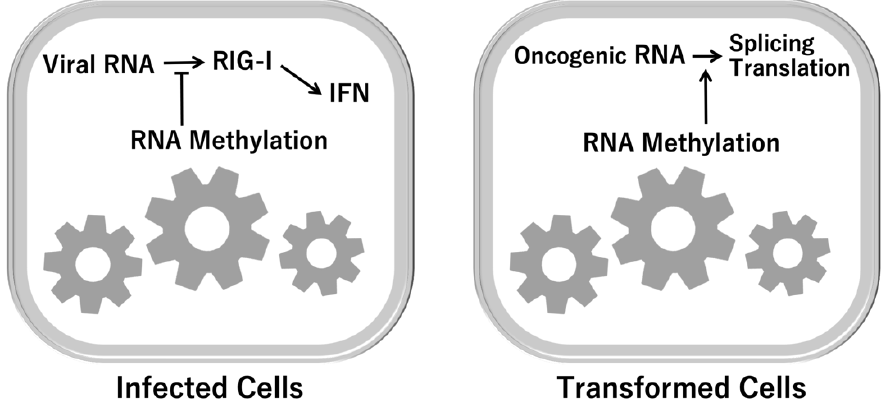
Figure 5. RNA-dependent immune response. As an output of 1C metabolism, RNA methylation is involved in the recognition of and response to exogenous RNA from viruses. RIG-I ATPase assists in the discrimination between self-RNA and non-self-RNA [33,34]. RIG-I, retinoic acid-inducible gene I; IFN, interferon.